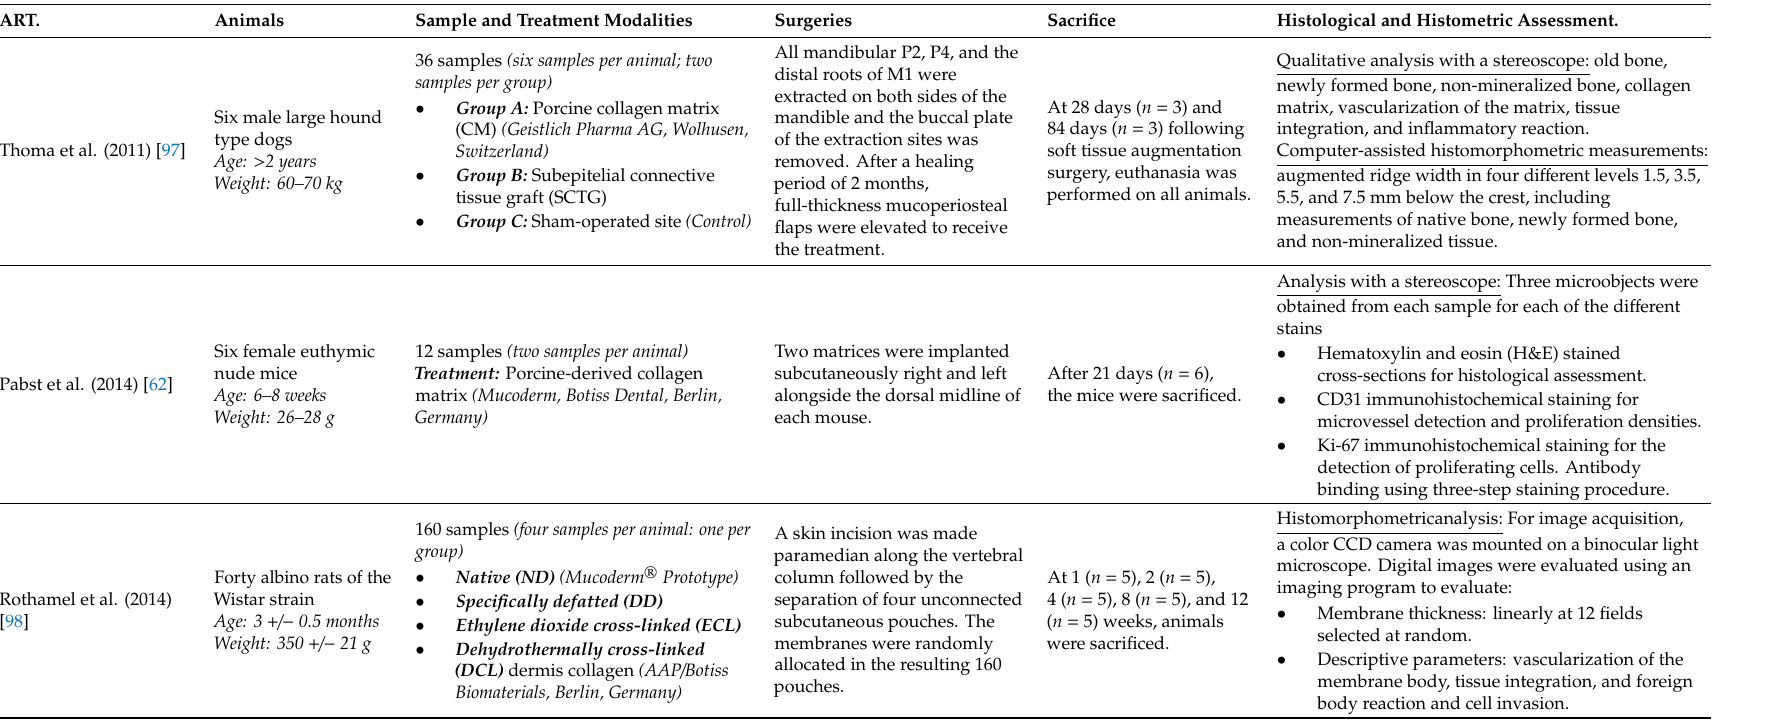
Table 1. Di ff erent animal models (dogs, mice, rats, or primates) can be submitted to soft tissue augmentation /